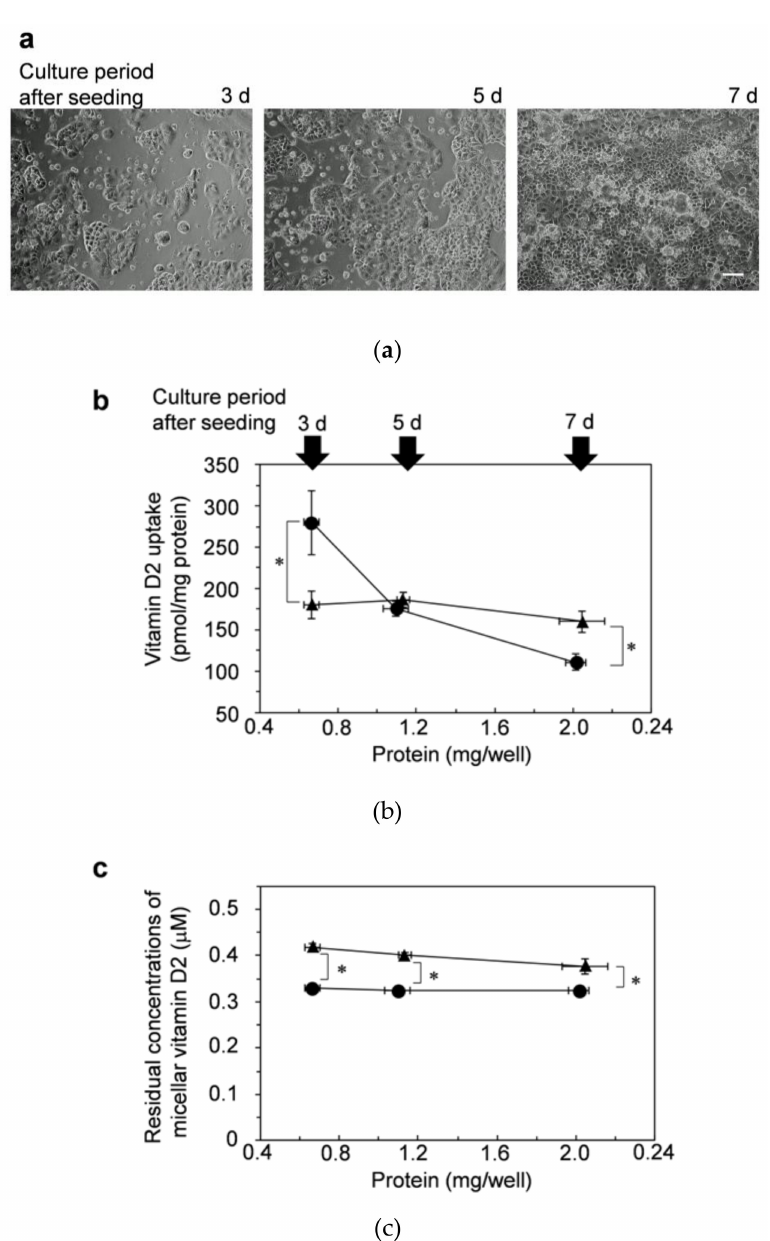
Figure 6. Effects of lysophosphatidylcholine on the uptake of vitamin D 2 by Caco-2 cells with insufficient cell-cell adhesion. Caco-2 cells with insufficient cell-cell adhesion/cell-matrix adhesion were prepared by cultivating for 3, 5, and 7 d after seeding in the culture plate. ( a ) These cells were observed by phase-contrast microscopy (100 × ). The white line in the photo of 7 d indicates the scale bar (100 µ m). The adhered Caco-2 cells were then incubated for 2 h with vitamin D 2 in NoPC mixed micelles (circles) and lysoPC mixed micelles (triangles). ( b ) Vitamin-D 2 uptake by the adherent Caco-2 cells. ( c ) Residual concentrations of the micellar vitamin D 2 after 2-h incubation with the cells. Data are presented as the means ± standard deviation of four wells in a single experiment. Replicate experiments showed a similar trend. Statistical analysis was performed between two mixed micelles at the same cultivation time (3, 5, and 7 d). The asterisk indicates a value with significant difference as determined by unpaired t -test ( p <